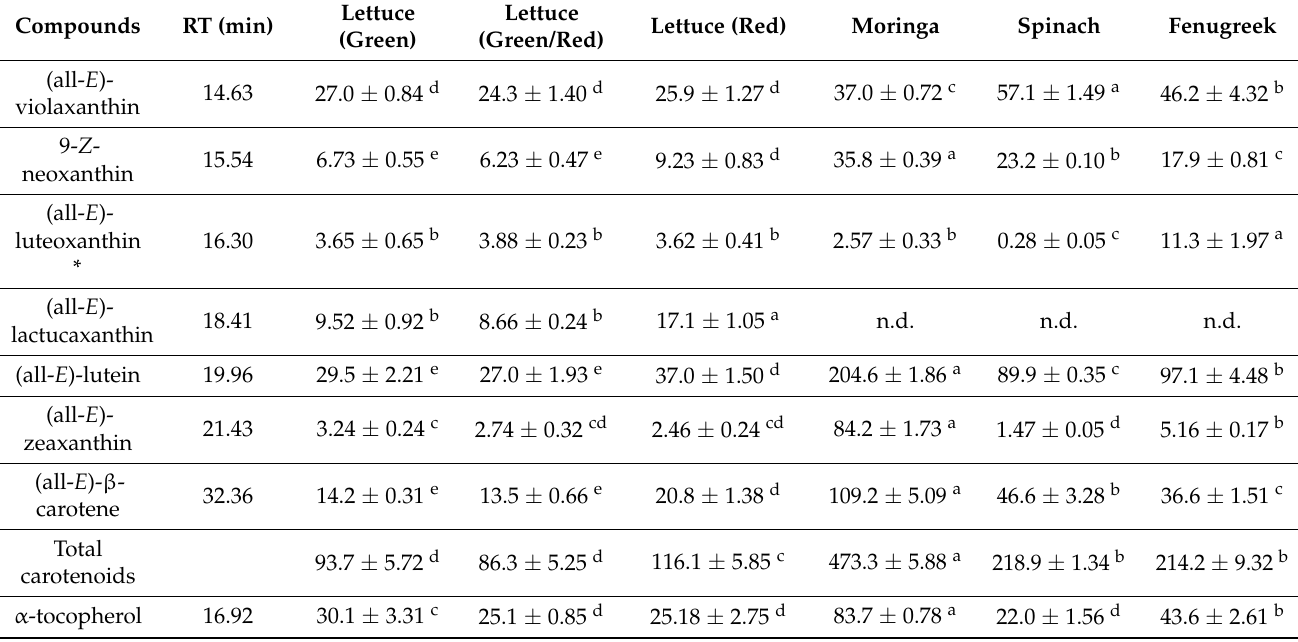
Table 4. The contents ( µ g/g FW) of carotenoids and α -tocopherol in studied